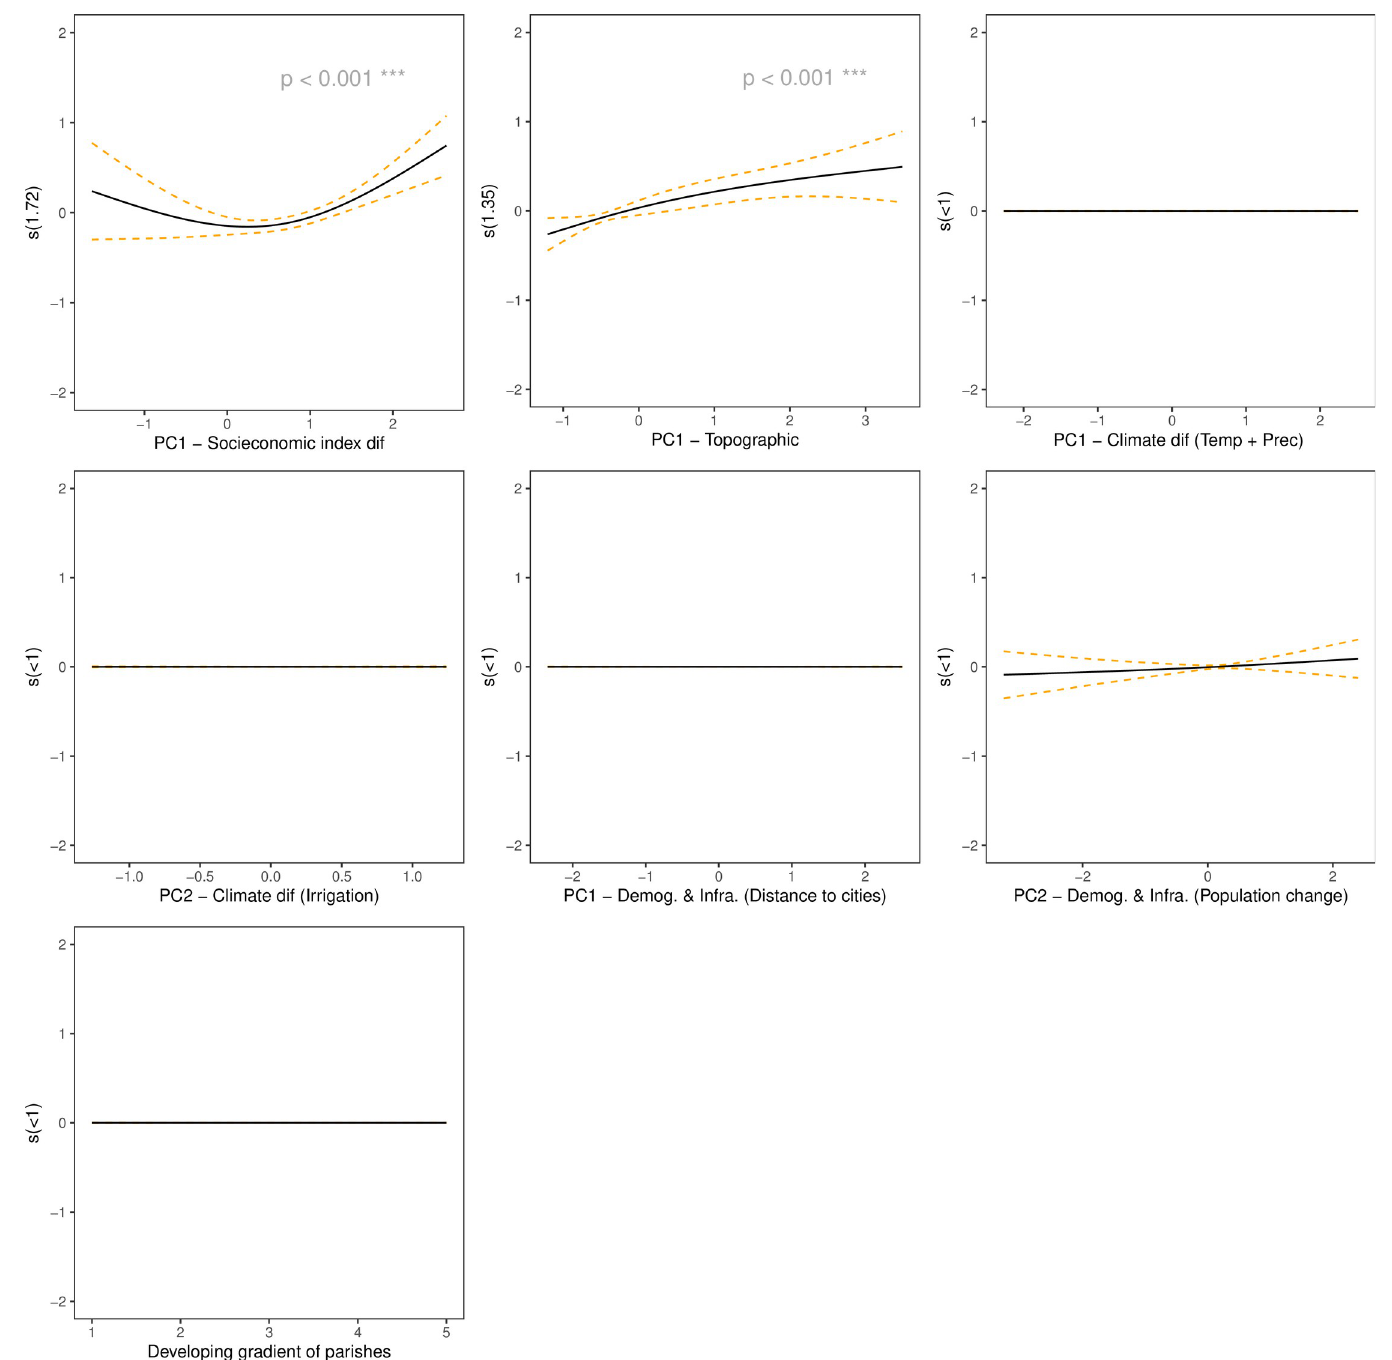
Fig 7. Generalized additive model partial dependence plots for native forest loss. Each plot shows a covariate and their partial dependence on probability of native forest loss in the context of the model. The y axis shows the mean of the probability of native forest loss and the x axis the covariate interval. The gray area represents the 95% confidence